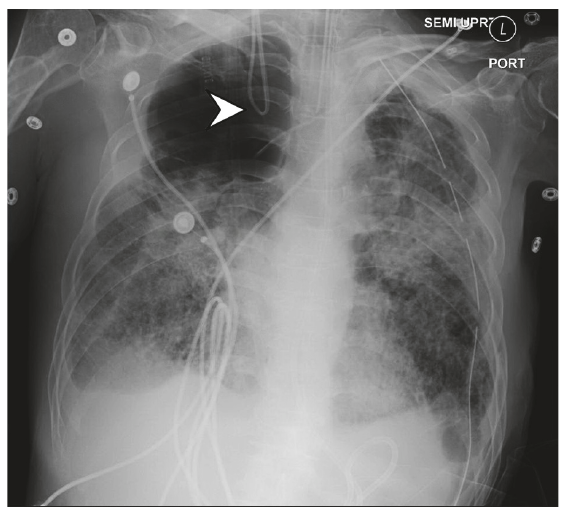
Figure 1: Portable chest x-ray with arrow depicting retrograde looping of pulmonary artery catheter.